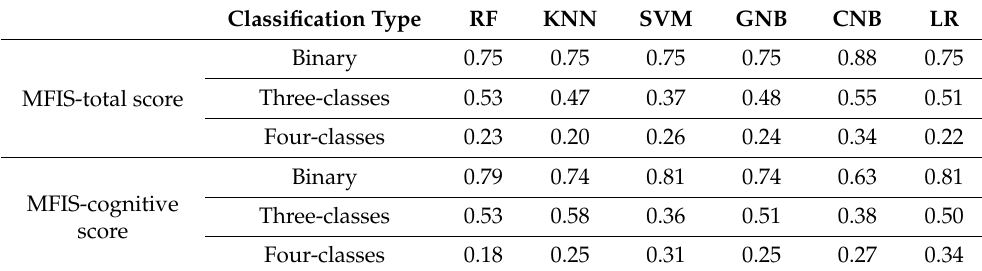
Table 2. Weighted average F1-scores of the classification models for predicting Modified Fatigue Impact Scale (MFIS)-total score and MFIS-cognitive score categorizations. The algorithms evaluated were random forest (RF), K-nearest neighbors (KNN), support vector machine (SVM), Gaussian naive Bayes (GNB), complement naive Bayes (CNB), and logistic regression (LR).